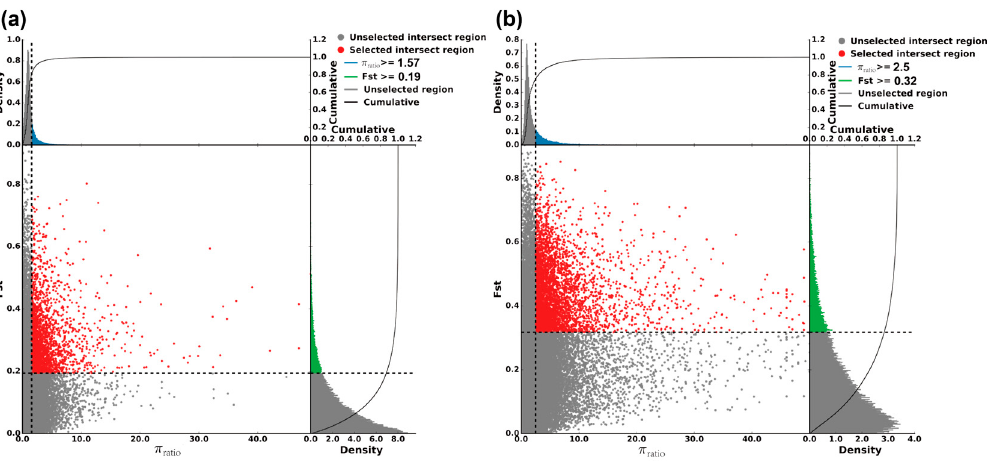
Figure 4. Genomic regions with selective sweep in MKS and WYL population: ( a ) MKS population; ( b ) WYL population.